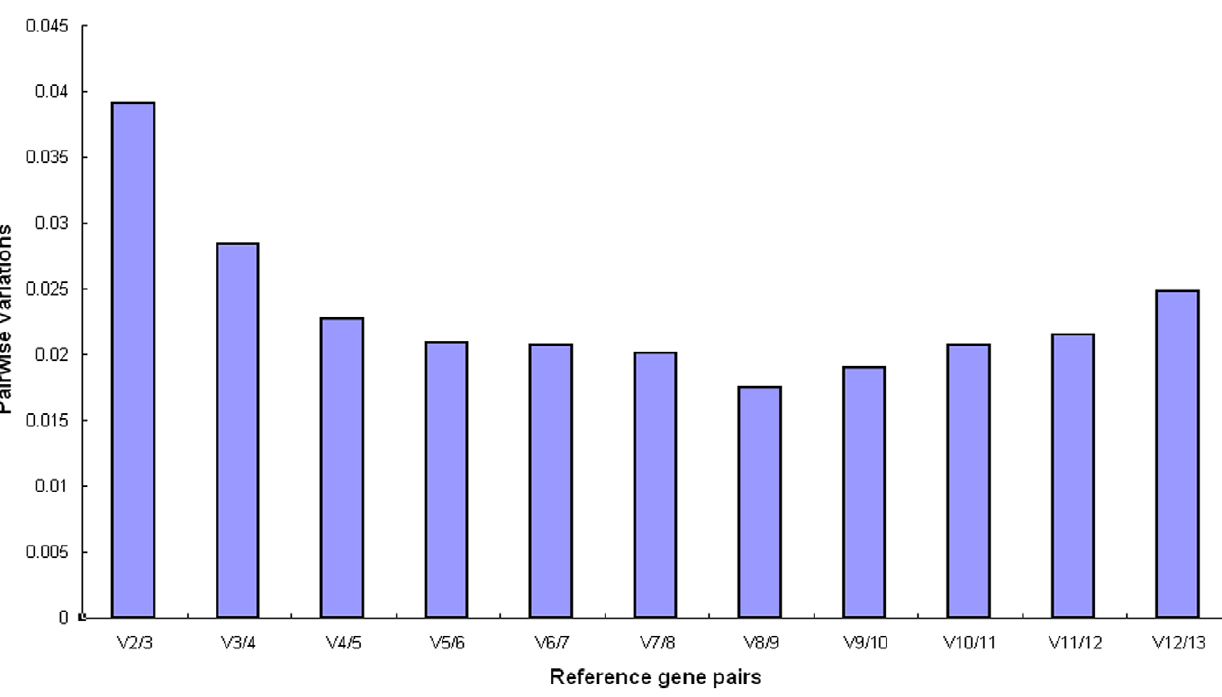
Figure 3. Determination of the optimal number of reference genes by geNorm analysis of the pairwise variation (V n/n + 1 ).